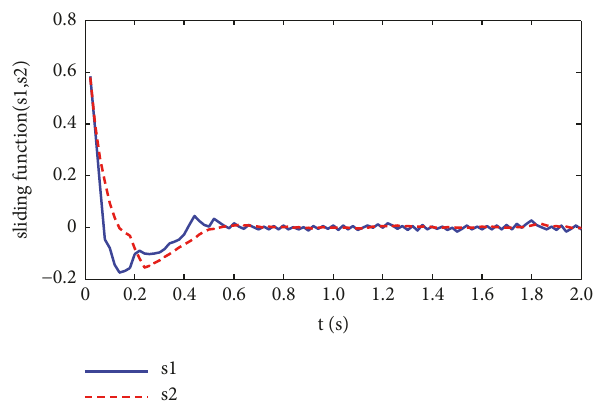
Figure 8: Sliding function trajectory with the classic reaching law based